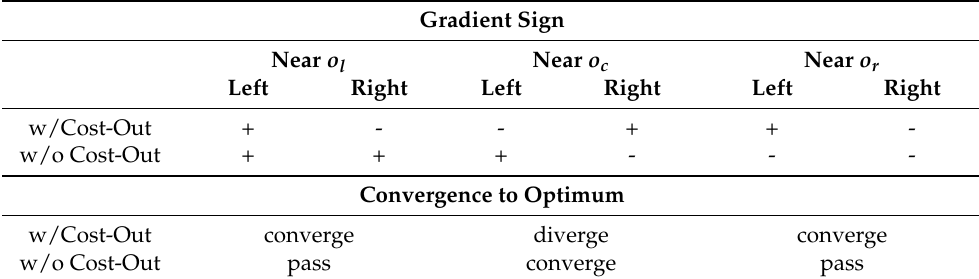
Figure 3. Comparison of convergence patterns between SGD + Cost-Out and other optimization methods. While there is only one optimum for Adam and AdaDelta, three possible optima exist for Cost-Out (i.e., gradient = 0): left ( o l ), center ( o c ), and right ( o r ). Table 2. Convergence to optima in conflict